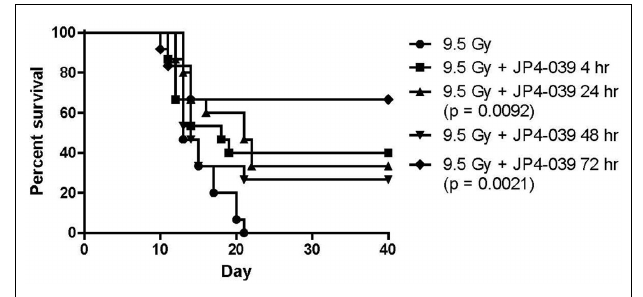
FIGURE 1 | Survival of groups of 15 C57BL/6NHsd mice given 20 mg/kg JP4-039 i.p. at varying times